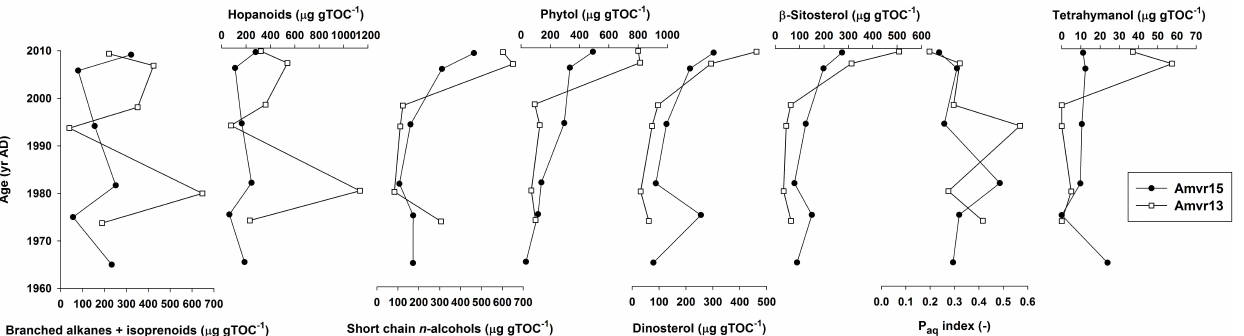
Fig. 6. Concentrations (µgg − 1 TOC) of the sums of branched alkanes and isoprenoids, hopanoids, short chain n -alcohols (C 11 –C 20 ), phytol, dinosterol, β -sitosterol, P aq index (by Ficken et al., 2000) and tetrahymanol plotted vs. age (yrAD).